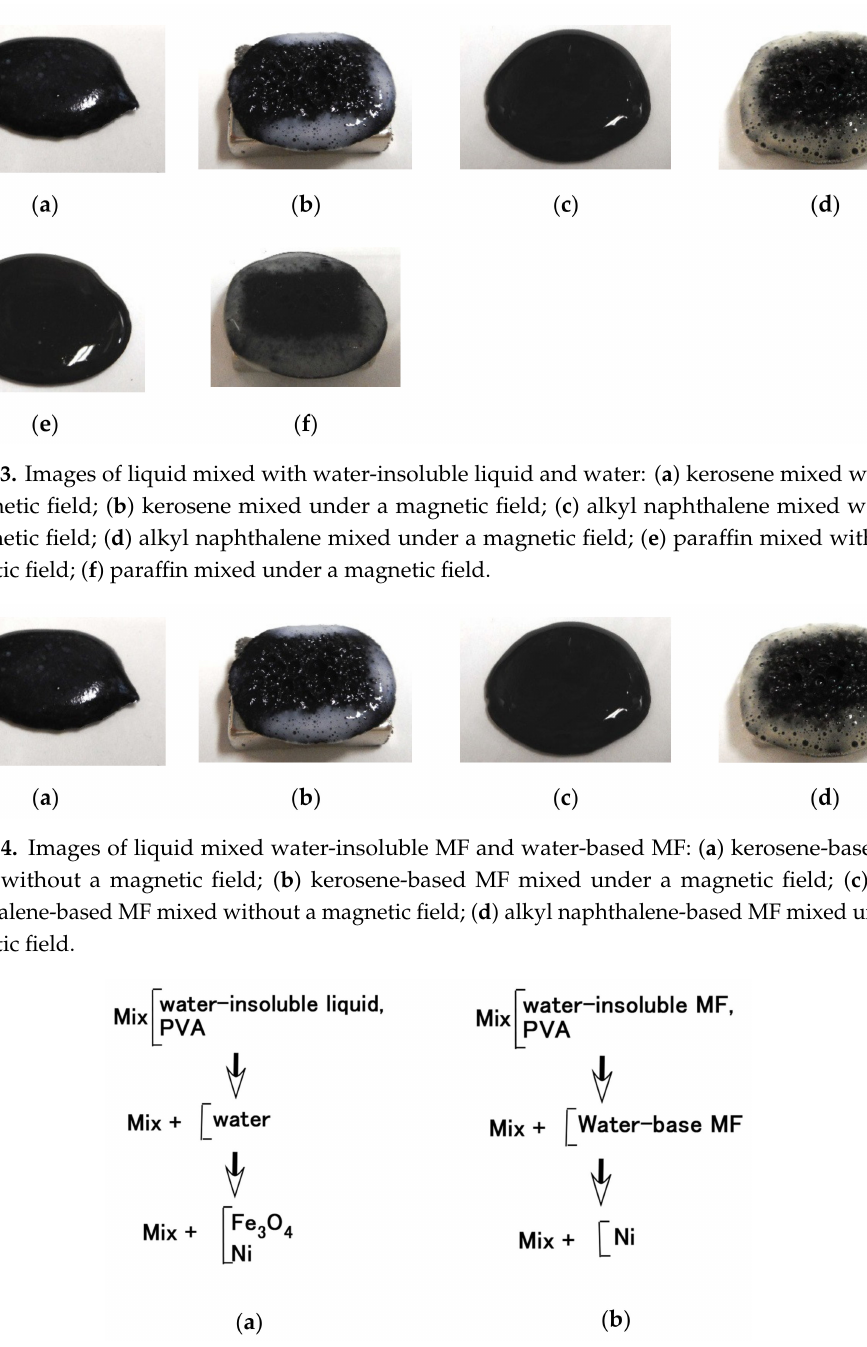
Figure 5. Mixing process; ( a ) for Figure 3; ( b ) for Figure